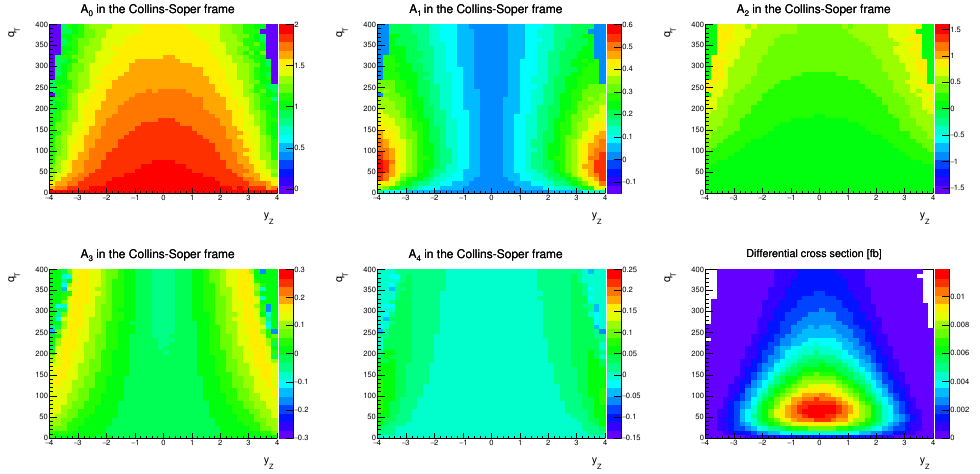
q T di(cid:11)erential cross section of the benchmark sce- (cid:0)